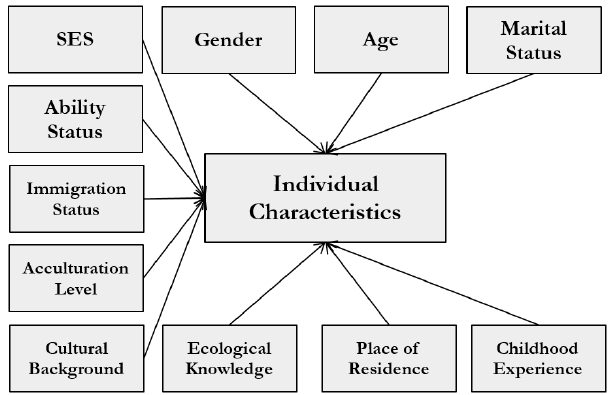
Figure 9: Individual characteristics